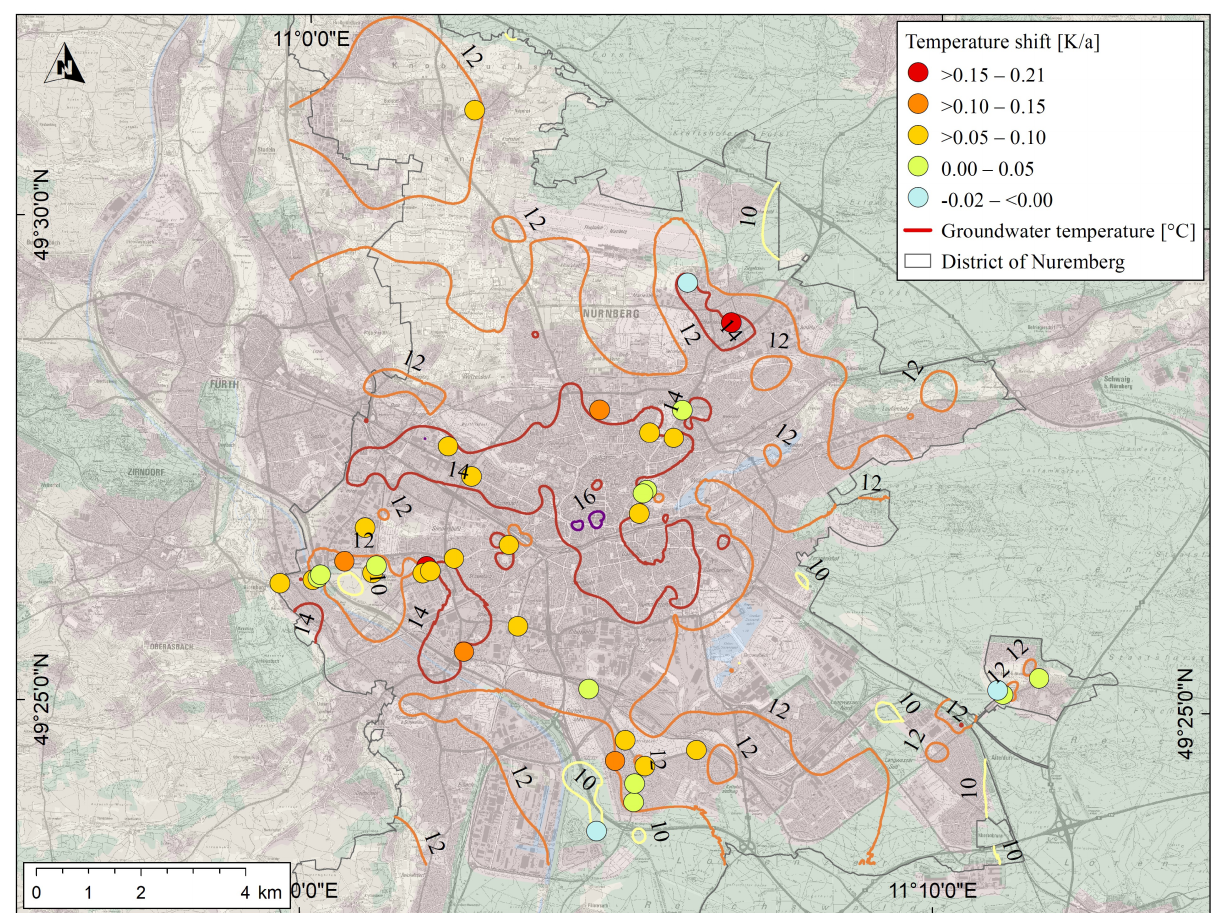
Figure 3. The subsurface urban heat island SUHI of Nuremberg is shown as an isotherm map with a contour interval of 2 K, calculated from more than 400 temperature data. The temperature peaks reached up to 17 ◦ C and were mainly measured near the center. In addition, the 38 observation wells are shown as a function of the calculated annual temperature shift from the years 2015–2020. The temperature shifts ranged from − 0.02 K/a to +0.21 K/a. Base maps: CORINE Land Cover, CLC2012; Geobasisdaten © Bayerisches Vermessungsverwaltung